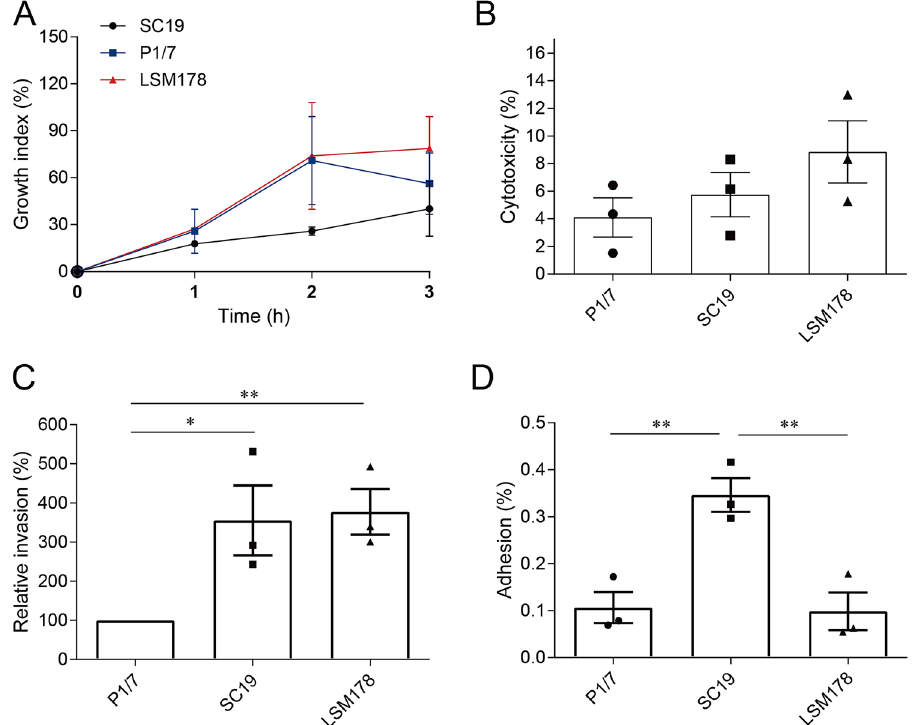
Figure 2. The resistance of LSM178, SC19 and P1/7 to human whole blood and expriments with Caco-2 cells. ( A ) The growth index of LSM178, SC19 and P1/7 in human whole blood. ( B ) The cytotoxicity of LSM178, SC19 and P1/7 to Caco-2 cells. ( C ) The relative invasion of LSM178, SC19 and P1/7 to Caco-2 cell. ( D ) The adhesion of LSM178, SC19 and P1/7 to Caco-2 cell. Invasion and adhesion were performed 3 h post infection. The data point represents the average of experimental repeats. P < 0.05 *, P < 0.01